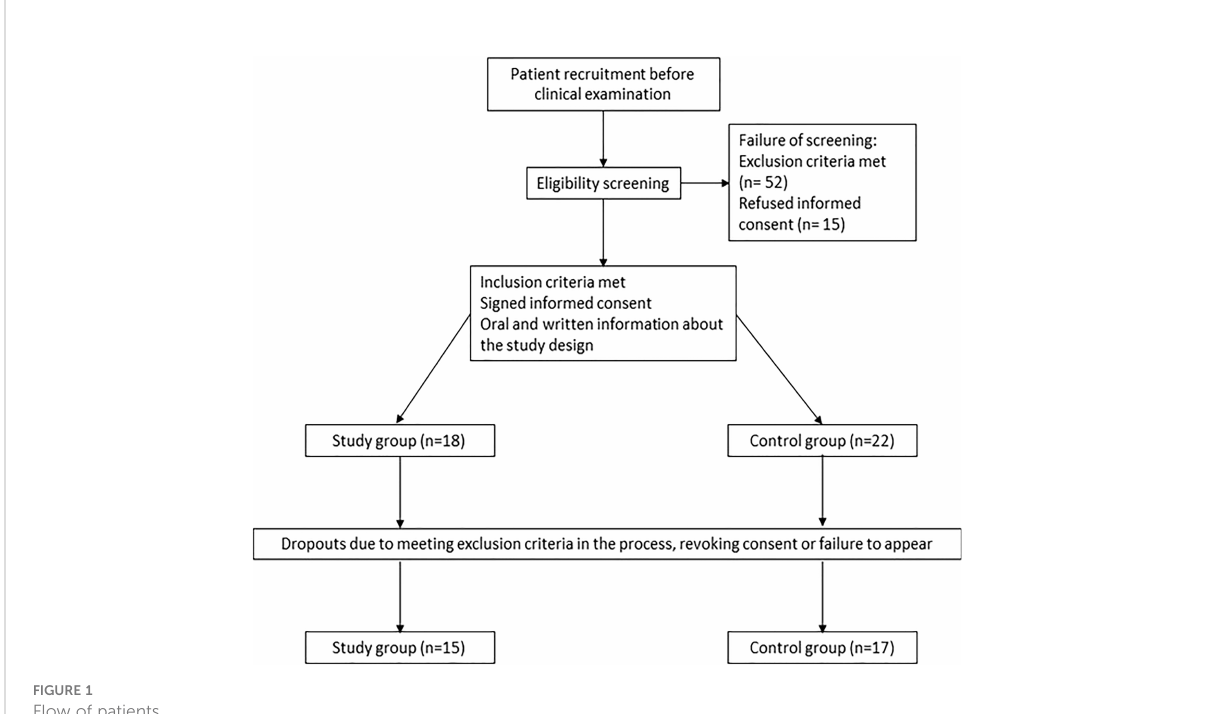
FIGURE 1 Flow of